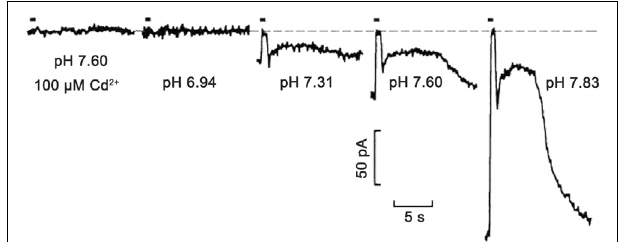
FIGURE 3 | Extreme pH sensitivity of synaptic transmission from photoreceptors to horizontal cells. Light responses to 500 ms bright light steps measured in a salamander horizontal cell under voltage-clamp were fully blocked at pH 6.94, to the same extent as in the presence of Ca V channel 100 µ M Cd 2+ at pH 7.6. Zero current is shown by the dashed line. As pH was increased to 7.31, 7.60, and 7.83, the postsynaptic, light-induced glutamate-gated current changes were produced by the hyperpolarizing cone light responses (in the figure, the short up-going currents aligned with light stimulus timing bar) and rod response (slower and longer upward deflections) become larger. This is due to the turnoff by the light of the increased glutamate release in the dark. The exponentially increasing response amplitudes at increasing pH levels were shown to be due to surface charge screening effects on the voltage-gated Ca V channels in presynaptic photoreceptors. Figure modified from Barnes et al.